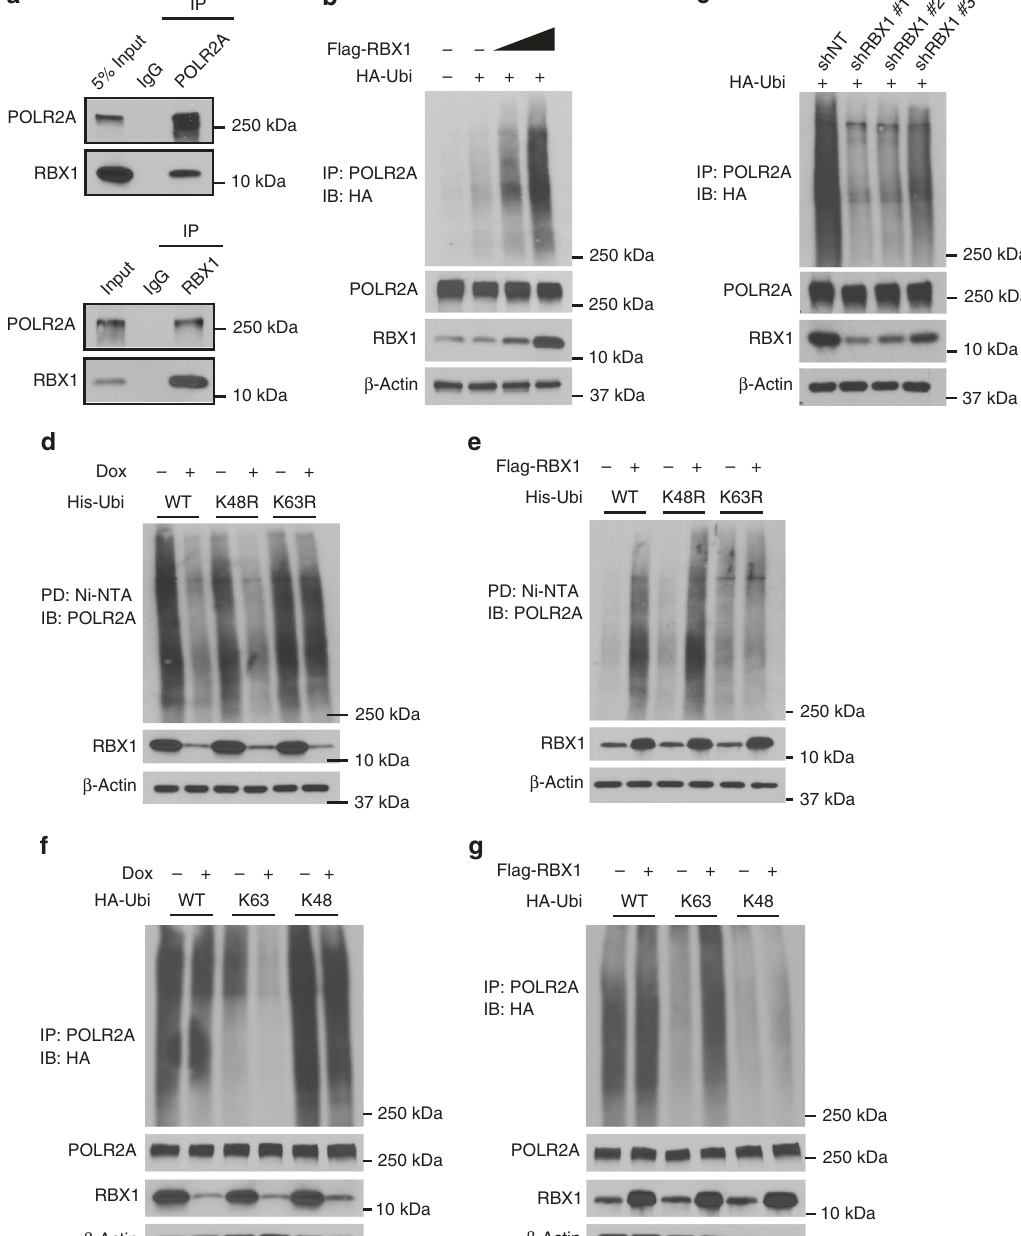
RBX1 depletion-sensitized 17p loss CRPC to POLR2A inhibi- tion . Our recent studies have shown that collateral deletion of POLR2A with TP53 in human colorectal cancer renders them susceptible to further inhibition of POLR2A 22 . Similarly, as observed in colorectal cancer, the POLR2A gene is almost always